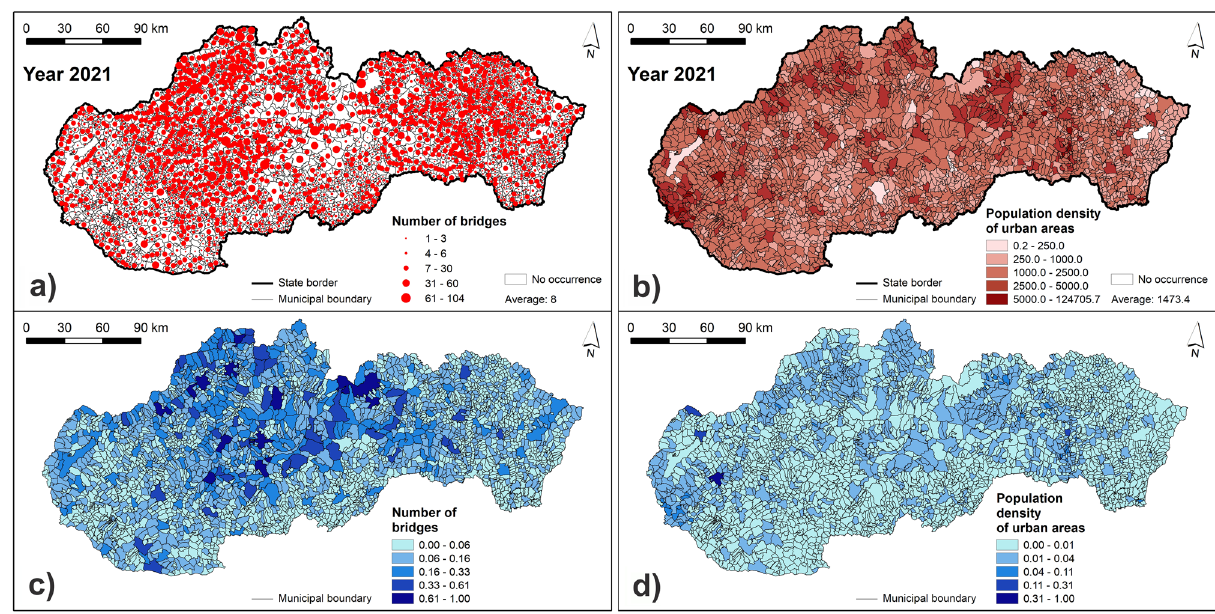
Figure 8. Indicators of the number of bridges and population density of urban areas: ( a ) original values of the number of bridges; ( b ) original values of the population density of urban areas; ( c ) normalized values of the number of bridges; ( d ) normalized values of the population density of urban areas. This figure was generated in ArcGIS 10.2.2 software.